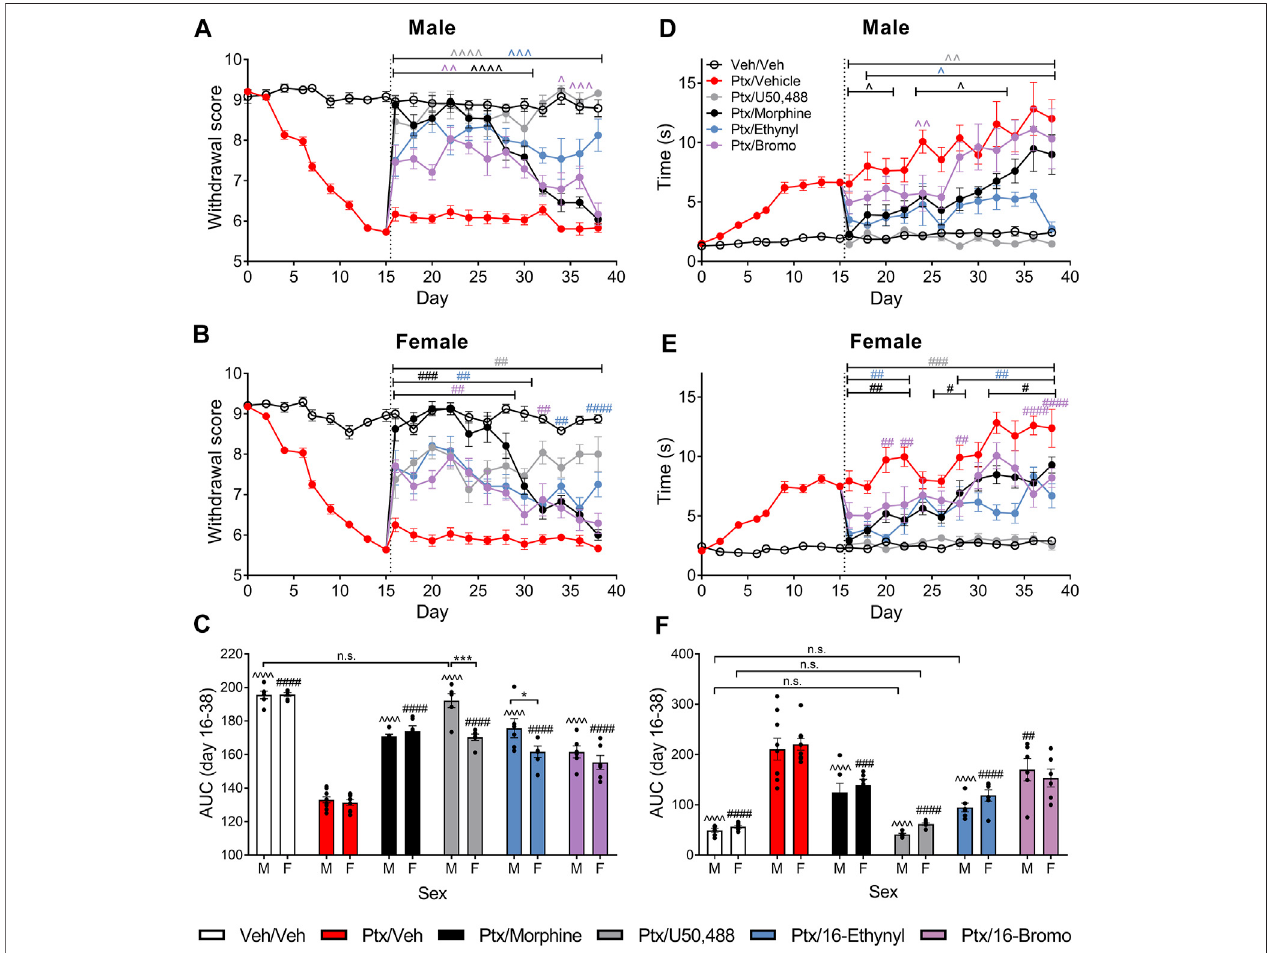
FIGURE 4 | Chronic KOR treatment reduced mechanical and cold allodynia in mice with established paclitaxel (Ptx)-induced neuropathic pain. (A, B) Time course ofthetreatmenteffectsofvehicle(Veh),morphine(10 mg/kg),U50,488(10 mg/kg),16-EthynylSalA(3 mg/kg),and16-BromoSalA(4 mg/kg)onmechanicalallodyniain (A) males and (B) females. (C) Area under the curve (AUC) comparison within the male and female animals showed treatments all signi fi cantly increased the paclitaxel- inducedwithdrawalscores,withU50,488treatmentinmalesimprovingthemechanicalthresholdstovehicle/vehiclelevels.Comparisonofthesexdifferencesinthe treatmentsfoundthatU50,488and16-Ethynylweremoreeffectiveinmales. (D,E) Timecourseofthetreatmenteffectsoncoldallodyniain (D) malesand (E) females. (F) AUC analysis showed that U50,488 treatment in both sexes and 16-Ethynyl treatment in males reduced the cold stimulus responding time to the same level as vehicle/ vehiclecontrols.Two-way ANOVA withBonferronipost-tests. n. s.=notsigni fi cant, ^ p < 0.05, ^^ p < 0.01, ^^^ p < 0.005, ^^^^ p < 0,001 formaletreatmentgroupcompared to malepaclitaxel/vehiclegroup; # p < 0.05, ## p < 0.01, ### p < 0.005,and #### p < 0.0001forfemaletreatmentgroupcomparedtofemalepaclitaxel/vehiclegroup;* p < 0.05, *** p < 0.005 for sex difference within treatment group. Values presented as mean ± SEM, n = 6 − 9.